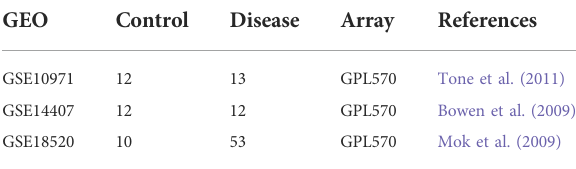
TABLE 1 Gene expression data sets used in this